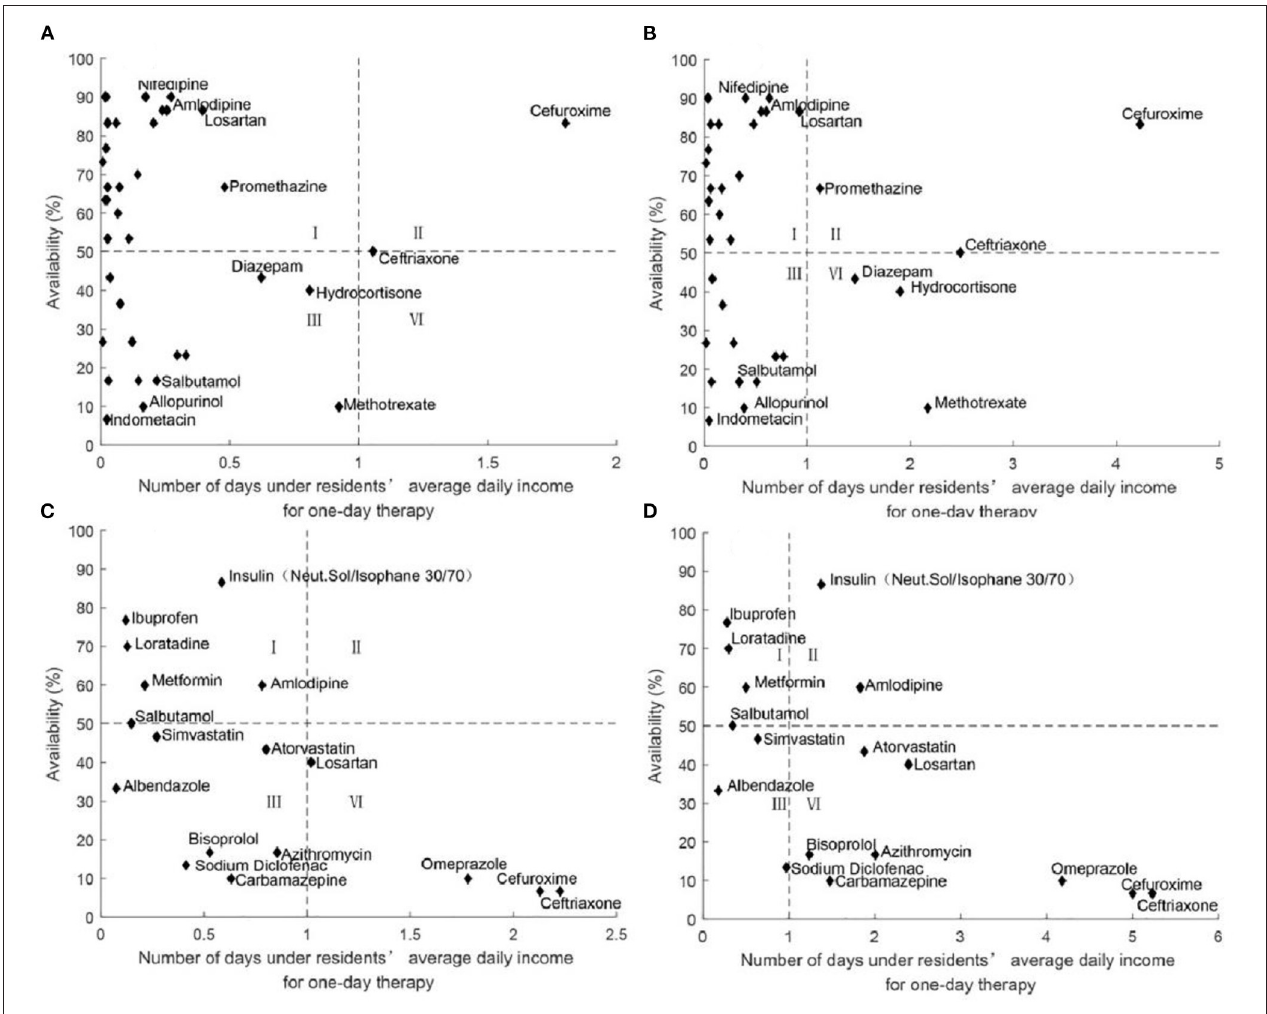
FIGURE 4 | Comprehensive analysis of medicine availability and affordability in 2018. (A) Comprehensive analysis of LPGs availability and affordability for urban residents. (B) Comprehensive analysis of LPGs availability and affordability for rural residents. (C) Comprehensive analysis of OBs availability and affordability for urban residents. (D) Comprehensive analysis of OBs availability and affordability for rural